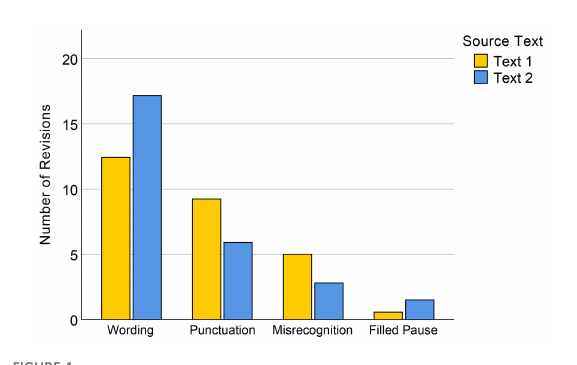
FIGURE 3 Proportions of the duration of each phase of the dictation group and the typing group.